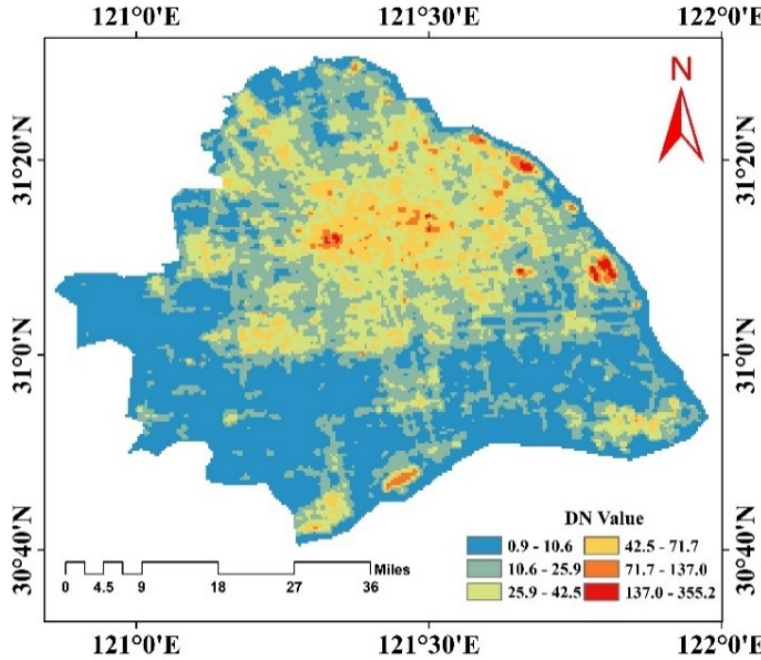
Figure 16. Night lighting data of main urban area of April 2018.